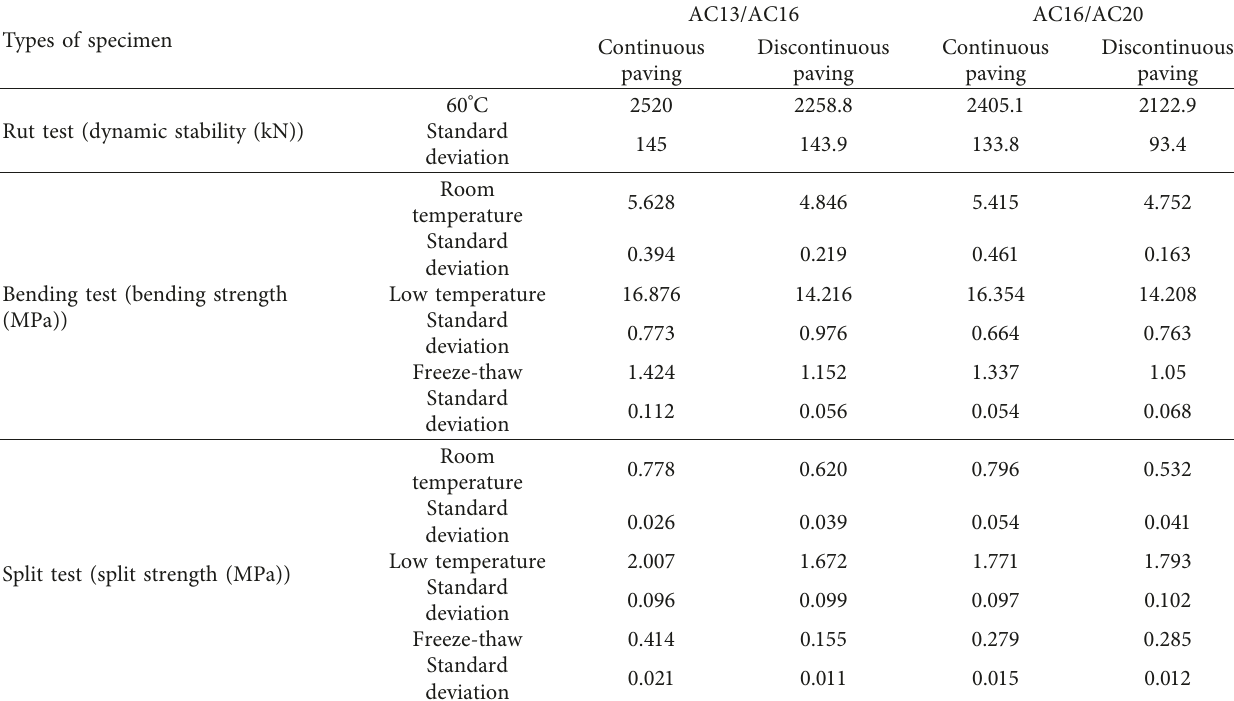
Figure 9: Working state of direct shear test. (a) Stress diagram of direct shear test. (b) Working state of direct shear Table 5: Results of test.